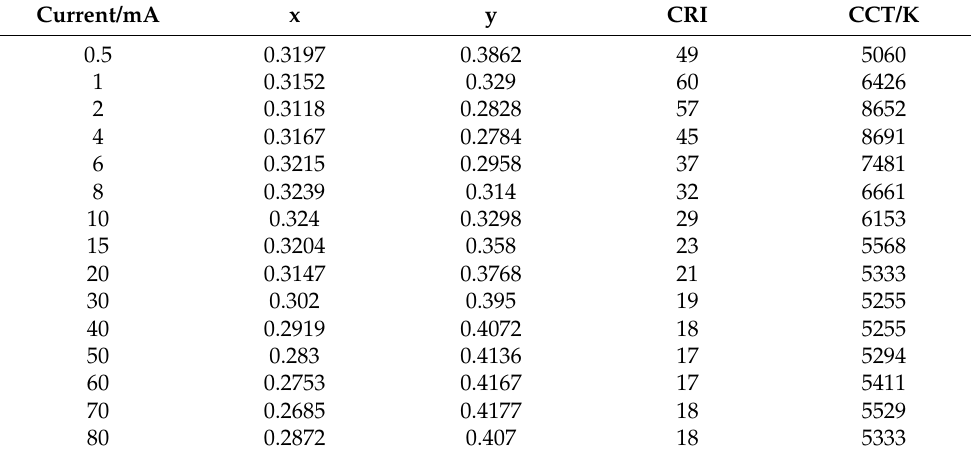
Figure 5. ( a ) The EL spectra from 0.5 mA to 80 mA. The inset is the I–V curve. ( b ) The chromaticity coordinates in the CIE1931 chromaticity diagram of the LED spectra under different current injection conditions. The empty red circles denote the chromaticity coordinates and the solid light grey circle indicates the white light location. Table 3. The chromaticity coordinates (x, y), CRI and CCT at different